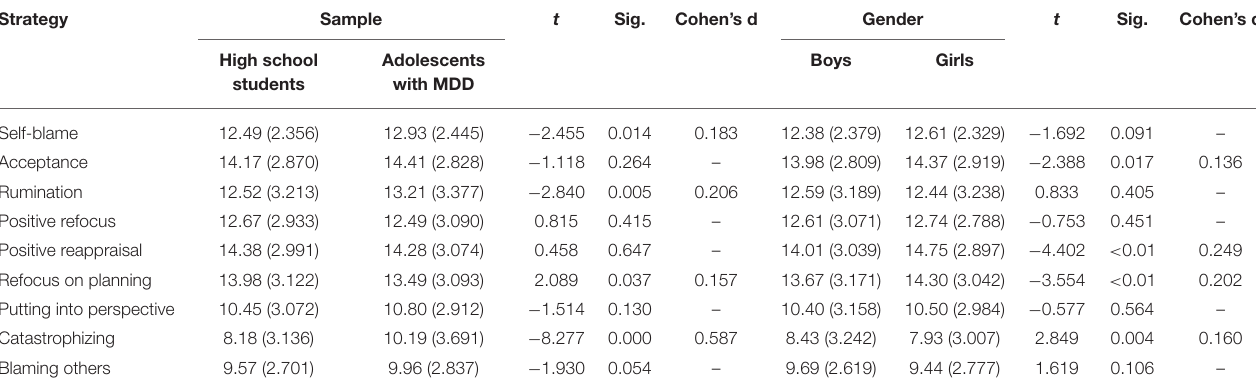
TABLE 9 | CERQ-C subscale mean score differences by presence of depression and